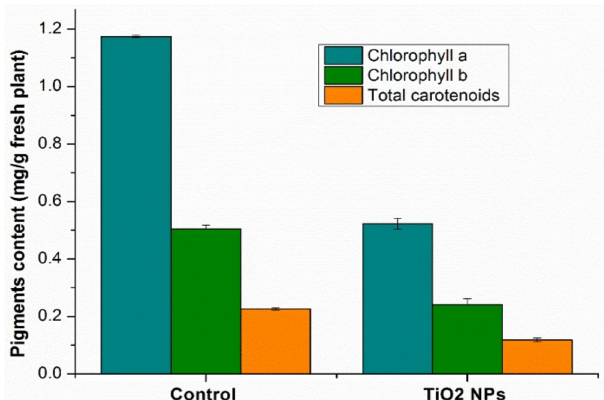
Figure 4. Comparative diagram of assimilating pigments. Each data point is the mean ± the standard error of the mean of three independent replicates experiments.